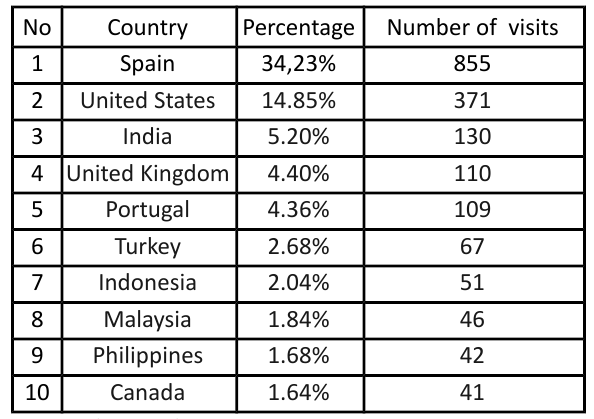
Table 2. JOTSE’s visits from 4th November 2015 to 20th January